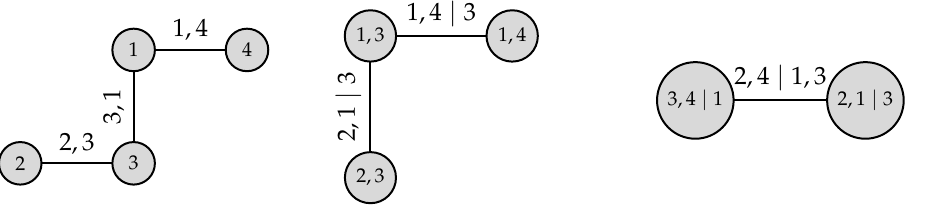
Figure 2. Vine tree